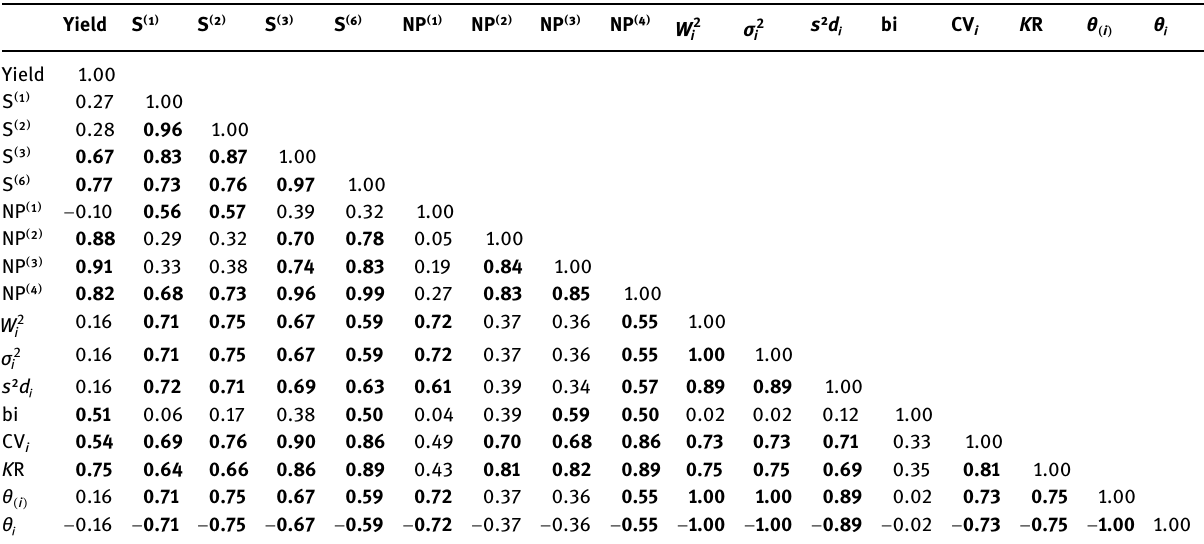
Table 5: Spearman ’ s correlation rank between storage root yield character with stability models Yield S ⁽ ¹